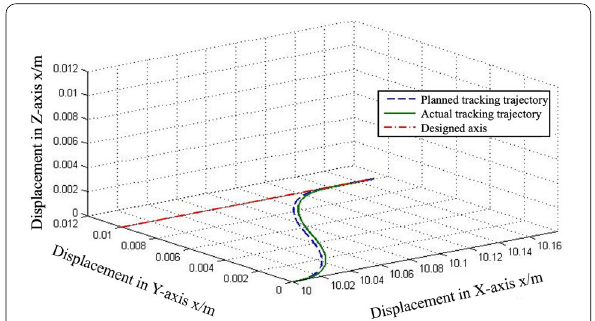
Figure 10 Tracking trajectory when deviation only in Y -axis